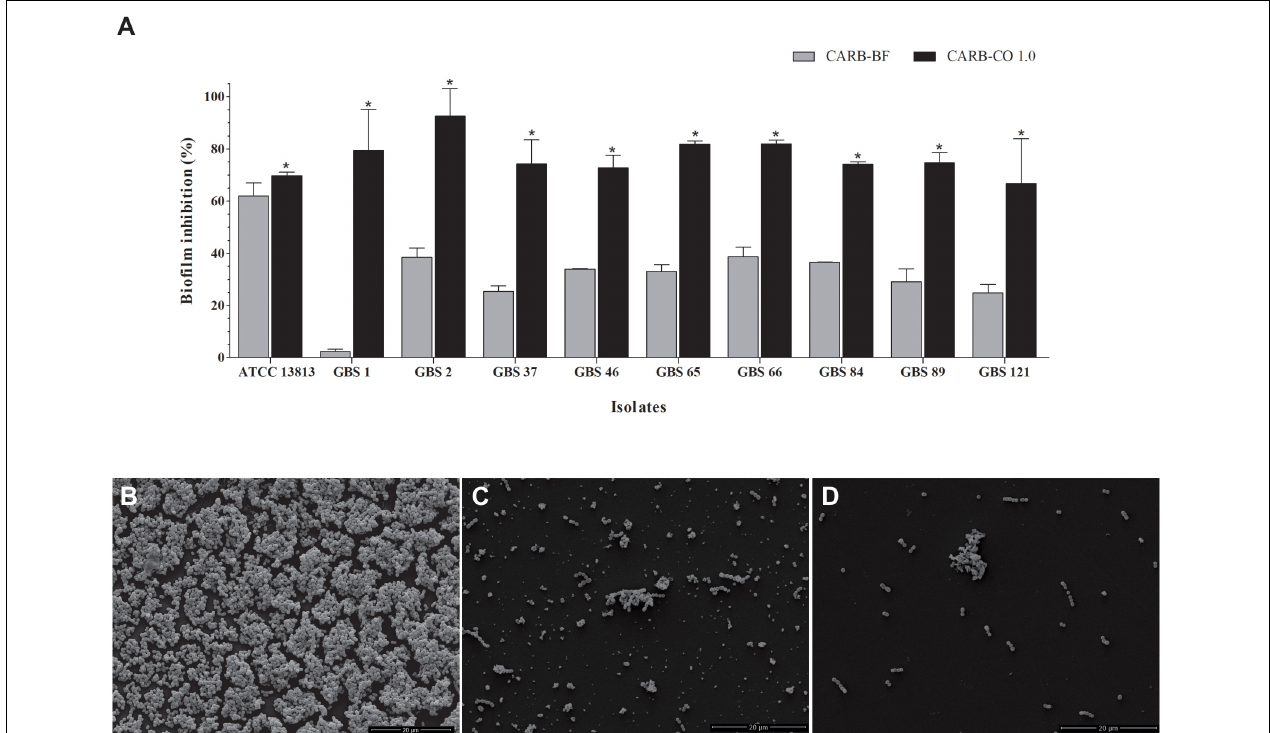
FIGURE 4 | Inhibitory effect of carbomer-based hydrogels on GBS biofilm formation. (A) CARB-CO 1.0 and CARB-BF were spread on the surface of flat-bottom 24-well plates. Biofilm was formed during 24 h at 37 ◦ C and CFU counts were determined. Values are mean ± standard deviation of two experiments. The asterisks indicate a significant percentage reduction of biofilm on polystyrene surface previously loaded with CARB-CO 1.0 compared to untreated ones ( ∗ P < 0.05). Scanning electronic microscopy images of biofilms formed on polystyrene surface for 24 h at 37 o C: untreated surface (B) , previously loaded with CARB-BF (C) or CARB-CO 1.0 (D) for 24 h at 37 ◦ C. Bar: 20 µ